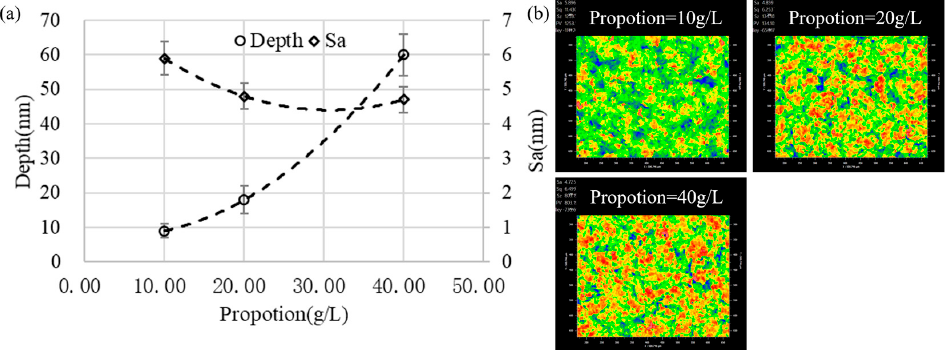
Figure 14. The influence of the fluid proportion on the removal pit: ( a ) the depth and the bottom surface roughness and ( b ) the bottom surface morphology (gap = 0.1 mm, time = 300 s, amplitude = 40 μ m).